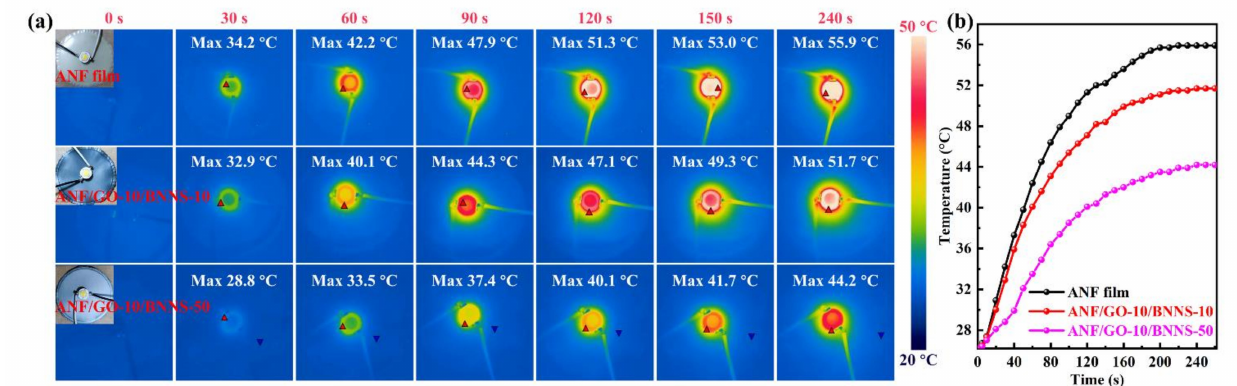
Figure 6. ( a ) Thermal infrared imaging of the LED chip at different working times using various heat spreaders of the ANF film, ANF/GO-10/BNNS-10, and ANF/GO-10/BNNS-50 (inset: Photographs of ANF film-based, ANF/GO-10/BNNS-10 composite film-based, and ANF/GO-10/BNNS-50 composite film-based LED devices). ( b ) Corresponding temperature-time